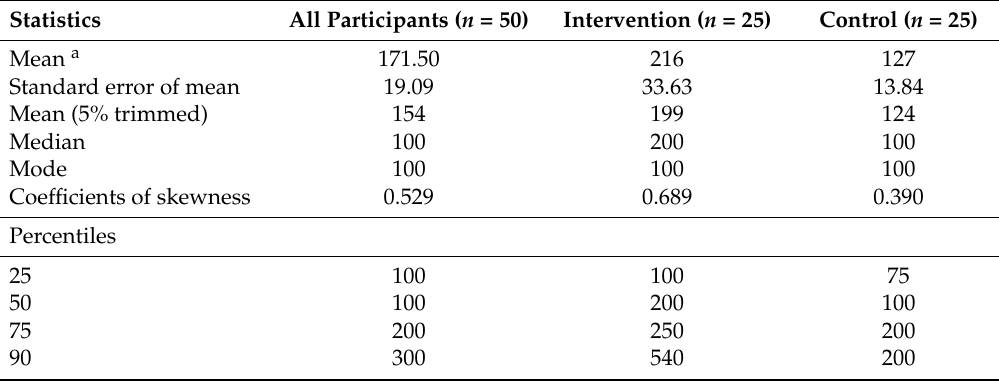
Table 3. Summary statistics for positive willingness-to-pay values